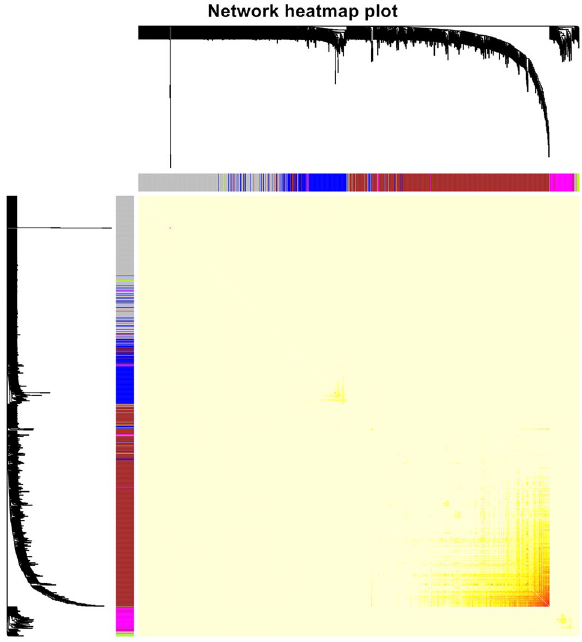
Figure 2. Heatmap plot of topological overlap in the gene network. In the heatmap, each row and column correspond to a gene, light color denotes low topological overlap, and progressively darker red denotes higher topological overlap. Darker squares along the diagonal correspond to modules. The gene dendrogram and module assignment are shown along the left and